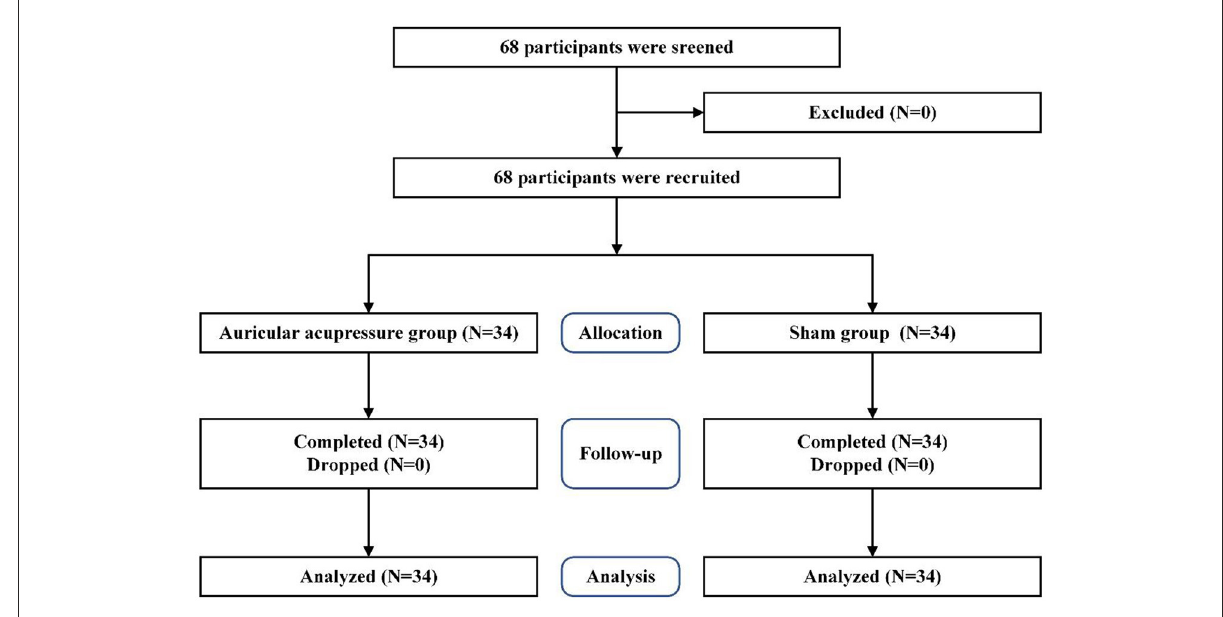
FIGURE1 CONSORT flow diagram of the